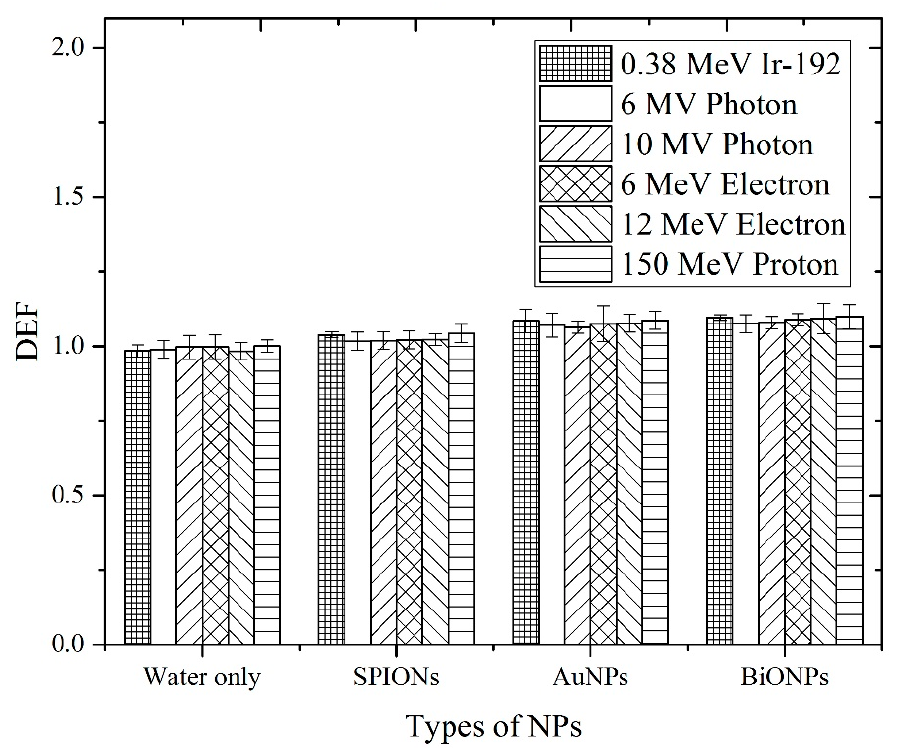
Figure 6. The physical DEF of different NPs obtained from the measurements using Gafchromic™ EBT3 films under several types of clinical radiotherapy beams (Ir-192, photon beams, electron beams and proton beam). Table 6. The physical DEF obtained from the measurements using Gafchromic™ EBT3 films.